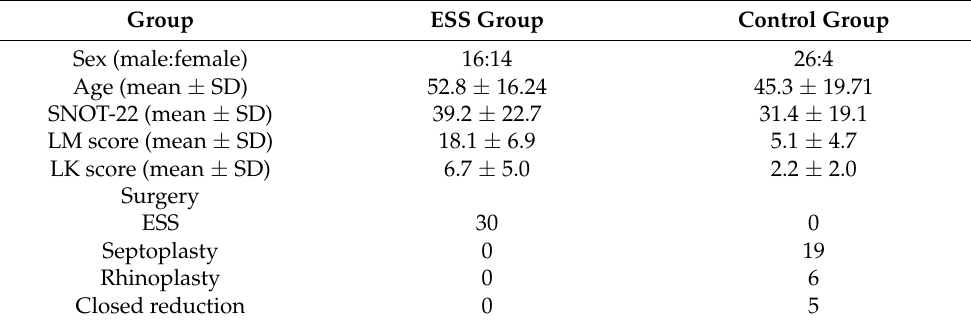
Table 1. Clinical characteristics of the patients.